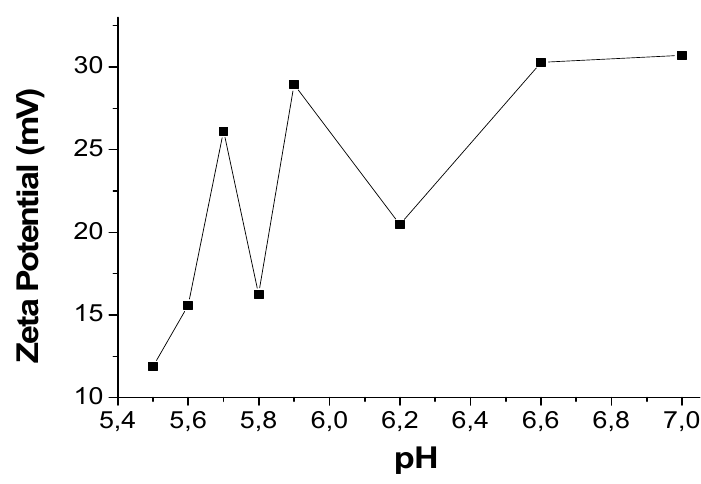
Figure 8. Z -potential values of 1n at different pHs.